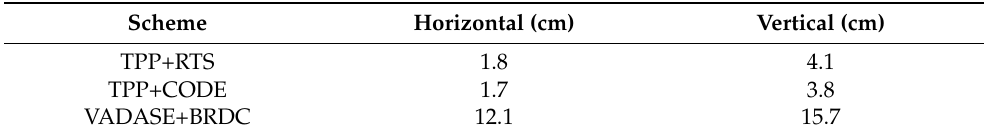
Table 3. The average RMS values of the retrieved displacements over 33 IGS stations for three different schemes.